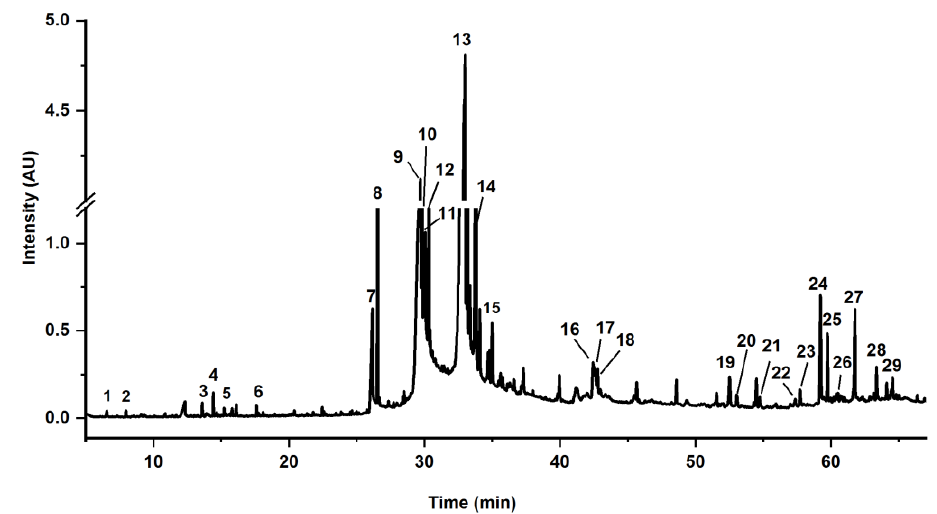
Figure 4. The GC-MS chromatogram of PE extracts from tung meal.